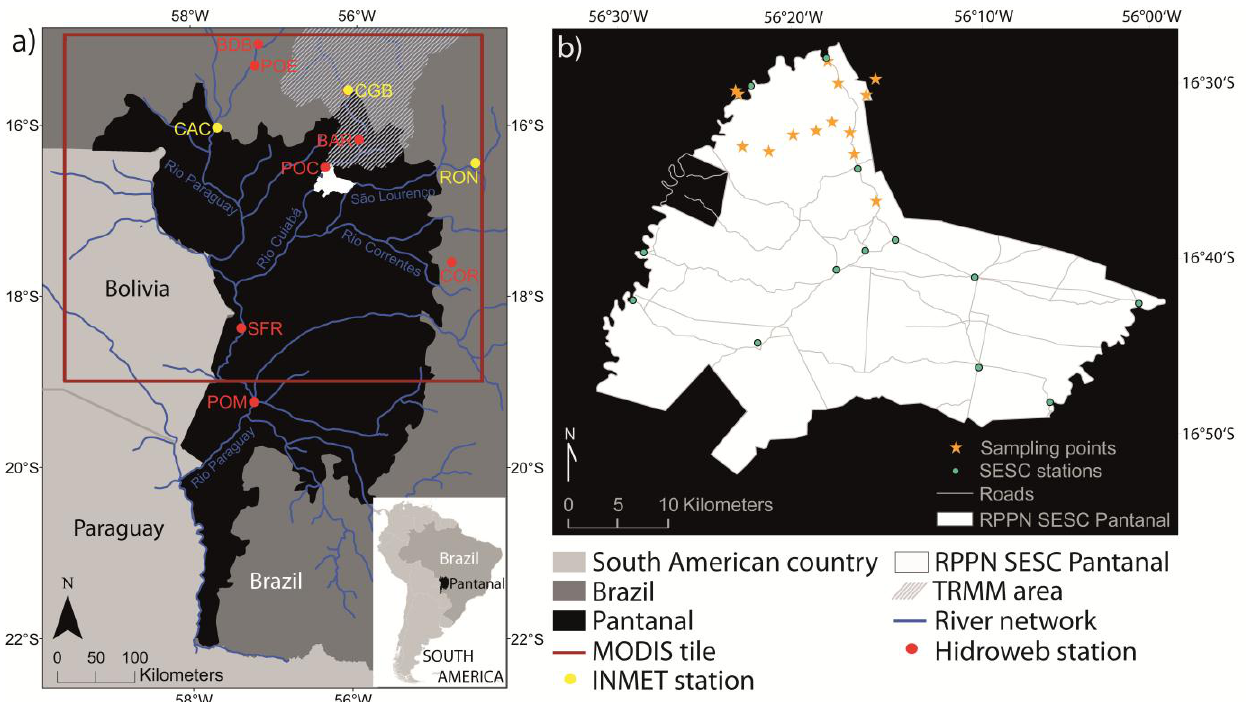
Figure 1. ( a ) Pantanal study area (RPPN ( Reserva Particular do Patrimônio Natural: Private reserve of national heritage) SESC ( Serviço Social do Comércio: Commercial Social Service) Pantanal, white) located in Central-Western Brazil (MODIS tile framed in red) with INMET ( Instituto Nacional de Meteorologia : National Institute of Meteorology) stations (yellow, CGB—Cuiabá, CAC—Cáceres, RON—Rondonópolis), Hidroweb stations from ANA (red, Agência Nacional de Águas : National Water Agency in Brazil; BDB—Barra do Bugres, POE—Porto Estrela, CGB—Cuiabá, BAR—Barão de Melgaço, POC—Porto Cercado, COR—Rio Correntes, SFR—São Francisco, POM—Porto da Manga) and TRMM (Tropical Rainfall Measuring Mission) area (striped). ( b ) Location of water level probes installed in the RPPN SESC Pantanal (modified from